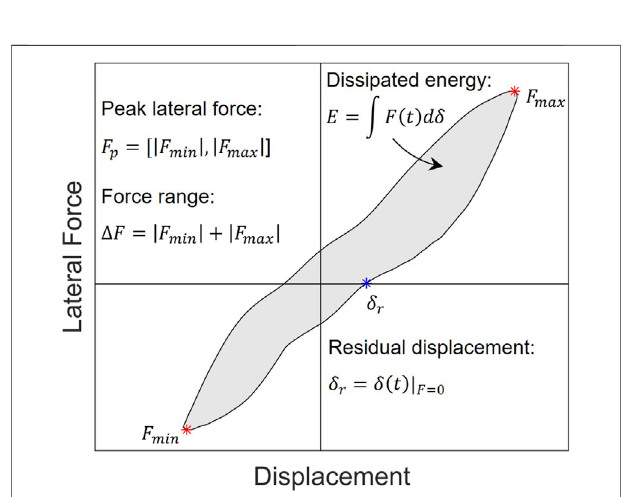
FIGURE 7 | De fi nition of engineering metrics for a sample force- displacement hysteresis loop.